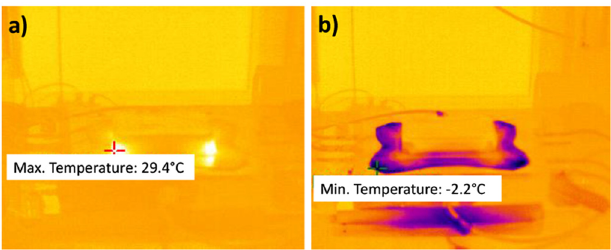
Fig. 20. Measured temperature on the sheet surface after deep drawing using (a) nitrogen and (b) liquid carbon dioxide